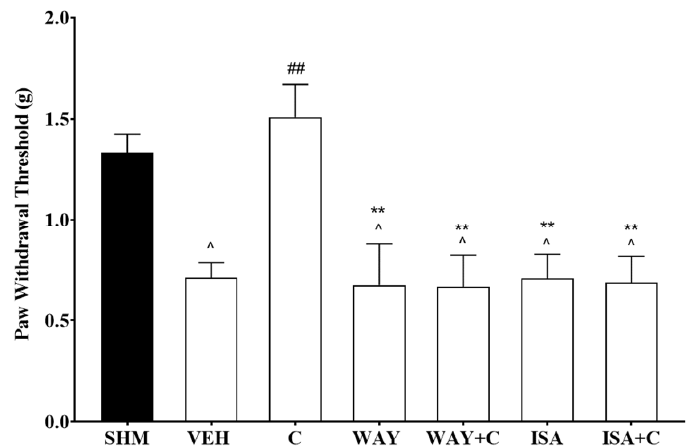
Figure 6. Effect of WAY 100,635 (5-HT1A receptor antagonist) and isamoltane (5-HT1B receptor antagonist) pre-treatment on cardamonin against mechanical allodynia of CCI-induced neuropathic pain mice were evaluated using von-Frey filament test. Data were presented as mean ± SEM ( n = 6). The caret, hash, and asterisks denote significance level (one-way ANOVA, followed by Tukey’s post hoc test. ˆ p < 0.05 as compared to sham, ## p < 0.01 as compared to vehicle and ** p < 0.01 as compared to cardamonin-treated group. SHM (Sham); VEH (Vehicle, 10 mL/kg i.p.); C (Cardamonin, 10 mg/kg i.p.); WAY (WAY 100635, 1.0 mg/kg, i.p.); ISA (Isamoltane, 2.5 mg/kg, i.p.).